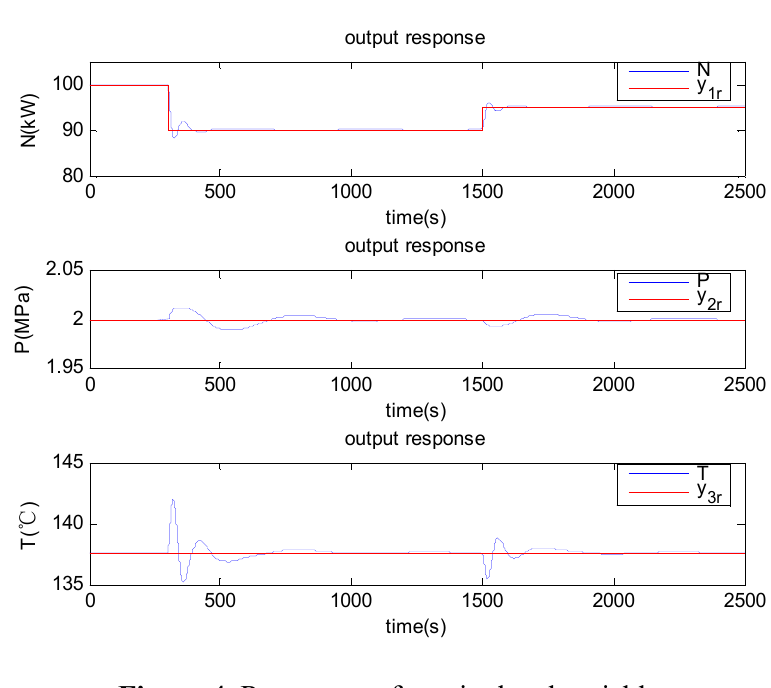
Figure 3. Responses of controlled variables.